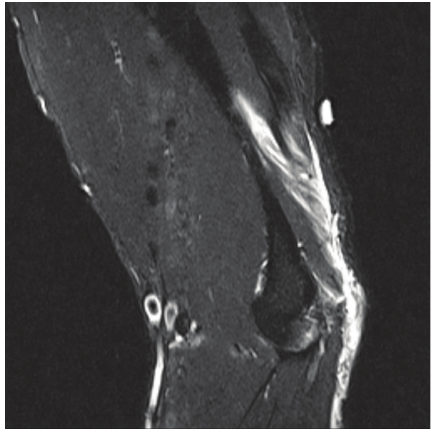
Figure 3: Right elbow, avulsion fracture through an enthesophyte at the triceps tendon insertion on the olecranon process of the right proximal ulna, with 9 mm of proximal retraction. There is underlying chronic tendinosis of the triceps tendon. No additional fractures are identified.